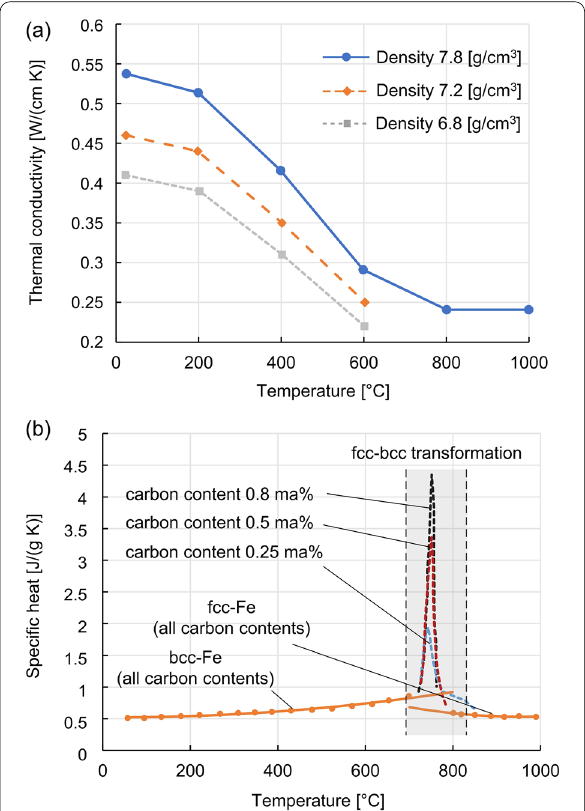
Figure 4 Thermophysical material data for the simulation of the case hardening: a thermal conductivity, b specific heat (according to Ref.